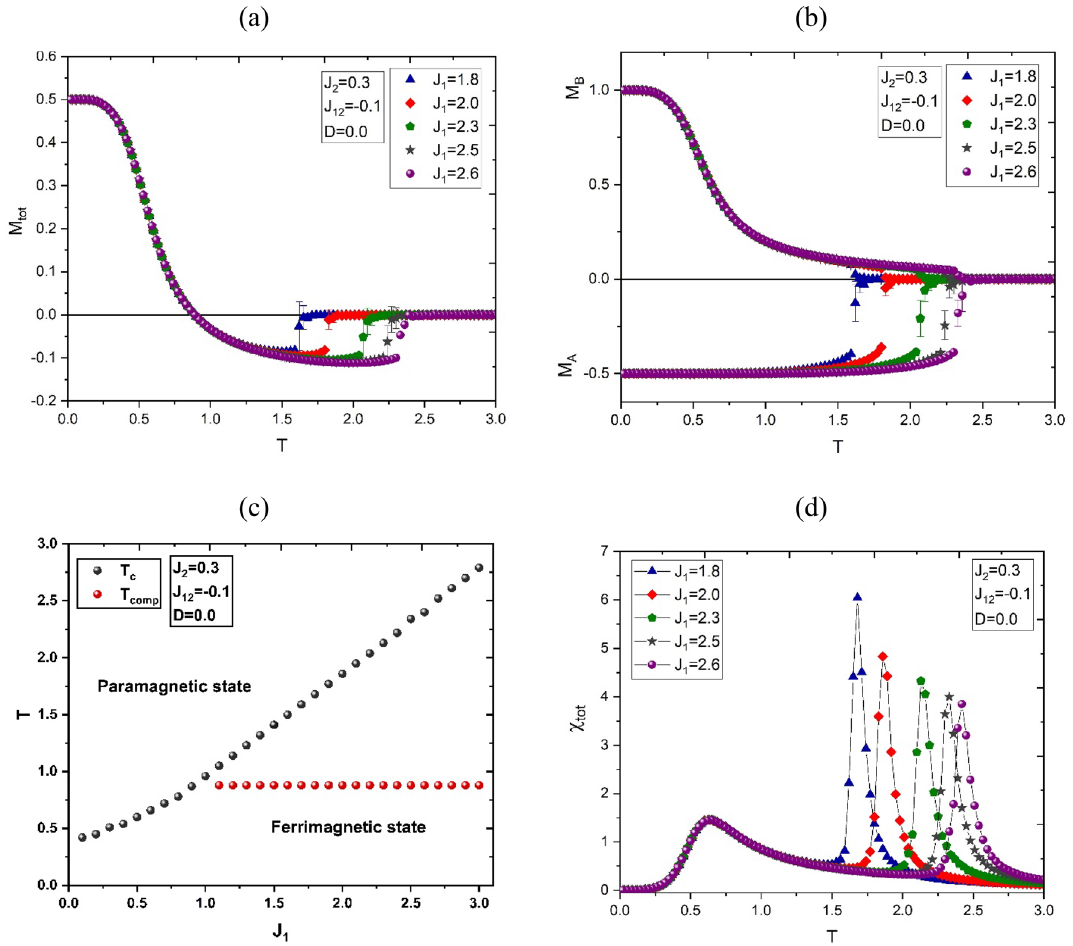
Fig. 2 Effect of J 1 coupling constant on a total magnetization, b sublattices magnetization, c critical and compensation temperature, and d total susceptibility of the system at fixed J 2 = 0.3, J 12 = − 0.1, D =